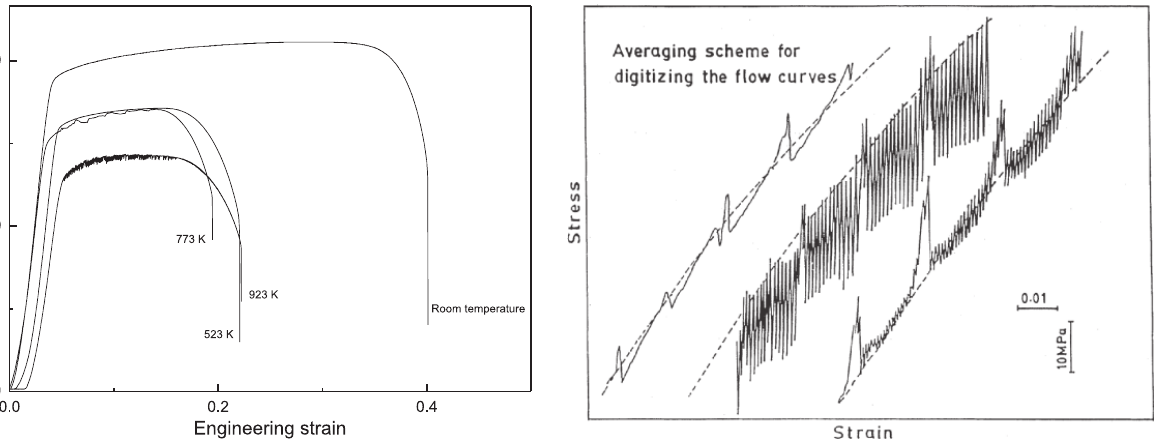
Fig. 1: Engineering stress-strain curves of ESR grade stainless steel.